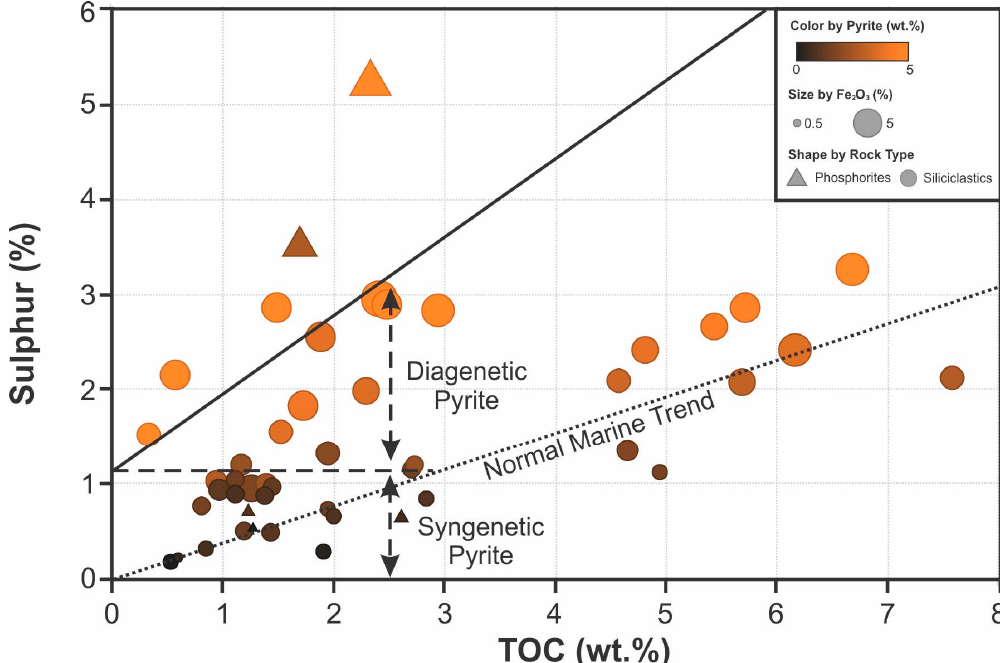
Figure 15. Crossplot of sulfur against TOC from Rock-Eval pyrolysis, with marker color by pyrite content, size by Fe 2 O 3 , and shape by rock type, showing two different populations according to pyrite content. Normal marine diagenetic pyrite trendline and a non-zero intercept trendline due to syngenetic pyrite (based on Raiswell and Berner [53]) are shown.